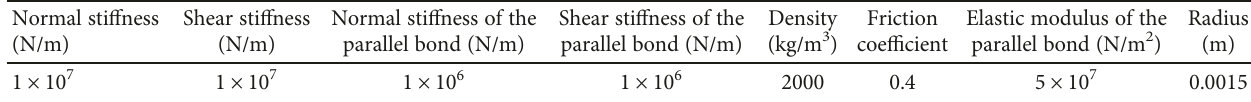
Table 3: Mesomechanical parameters of the barrier.